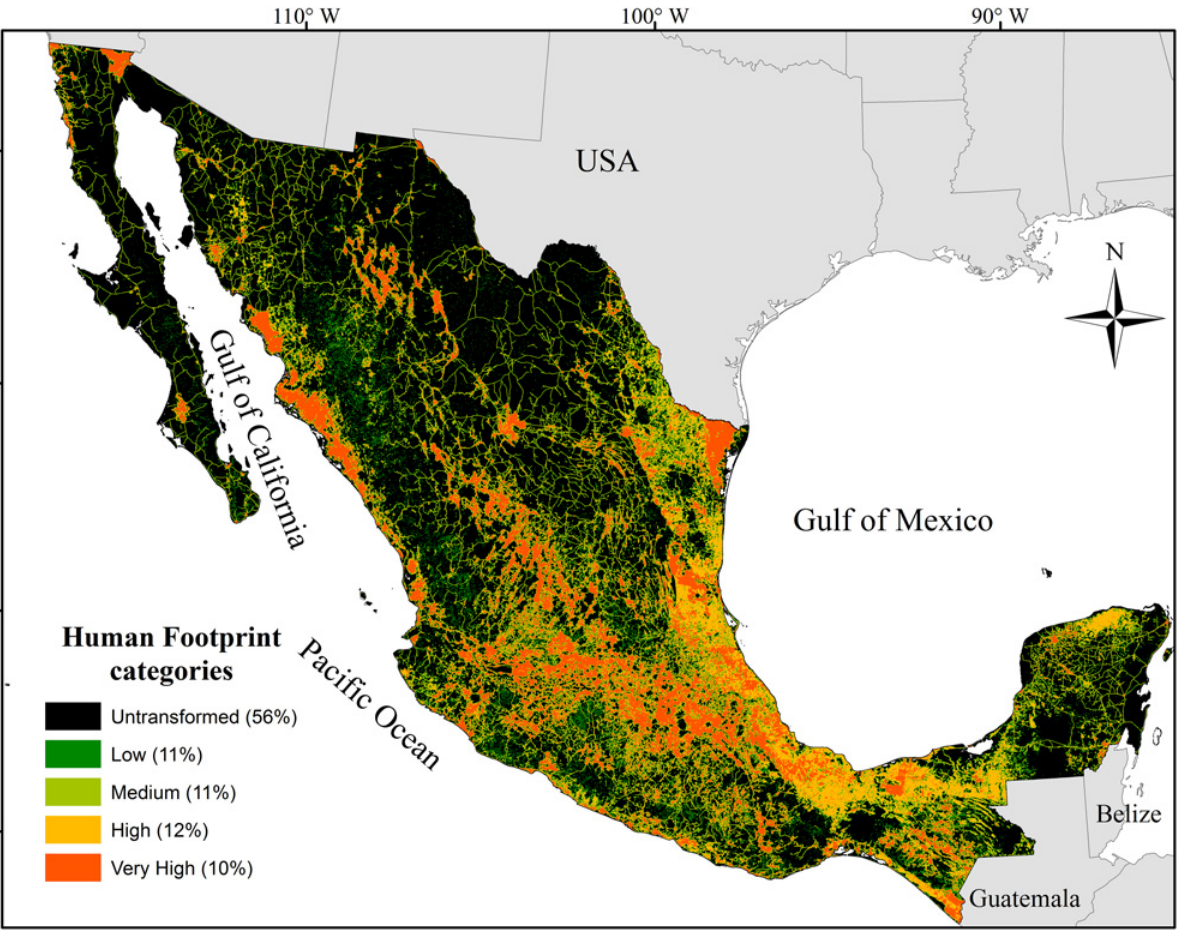
Fig 1. Human footprint map. The areas in black show with the highest human footprint values in a well-defined spatial pattern. They run along the coastal plains of the Gulf of Mexico and from there inland along an east-to-west corridor that follows the Mexican transversal volcanic ranges and the associated upland plateau. The areas in black represent the lowest values of human footprint located on Mexico ’ s arid northwest and its tropical southeast (chiefly the Yucatán peninsula).